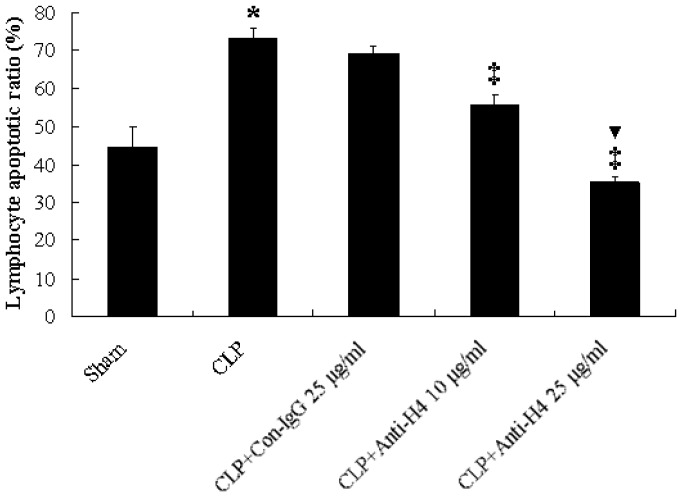
Extracellular histone H4 neutralization antibody blocked human peripheral lymphocyte apoptosis induced by plasma of sepsis mouse model dose-dependently.Isolated human lymphocytes were exposed to 20 µl plasma of sham or CLP mice with various concentrations of H4 neutralization antibody (0, 10, 25 µg/ml) and control IgG (25 µg/ml). Lymphocytes were harvested at 2 h and apoptotic ratio was detected by Flow-cytometry. Values are presented as means ± SD (n = 3). *P<0.05, as compared with sham. ‡P<0.05, as compared with CLP group. ▾ P<0.05, as compared with CLP+Anti-H4 10 µg/ml group.